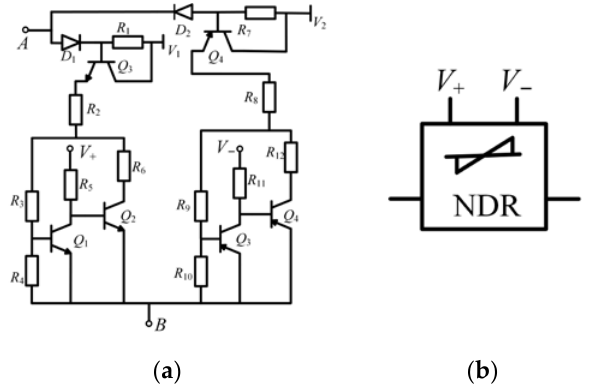
Figure 4. Improved NDR hysteresis circuit and its simplified symbol: ( a ) improved NDR hysteresis circuit, ( b ) the simplified symbol of improved NDR hysteresis circuit.